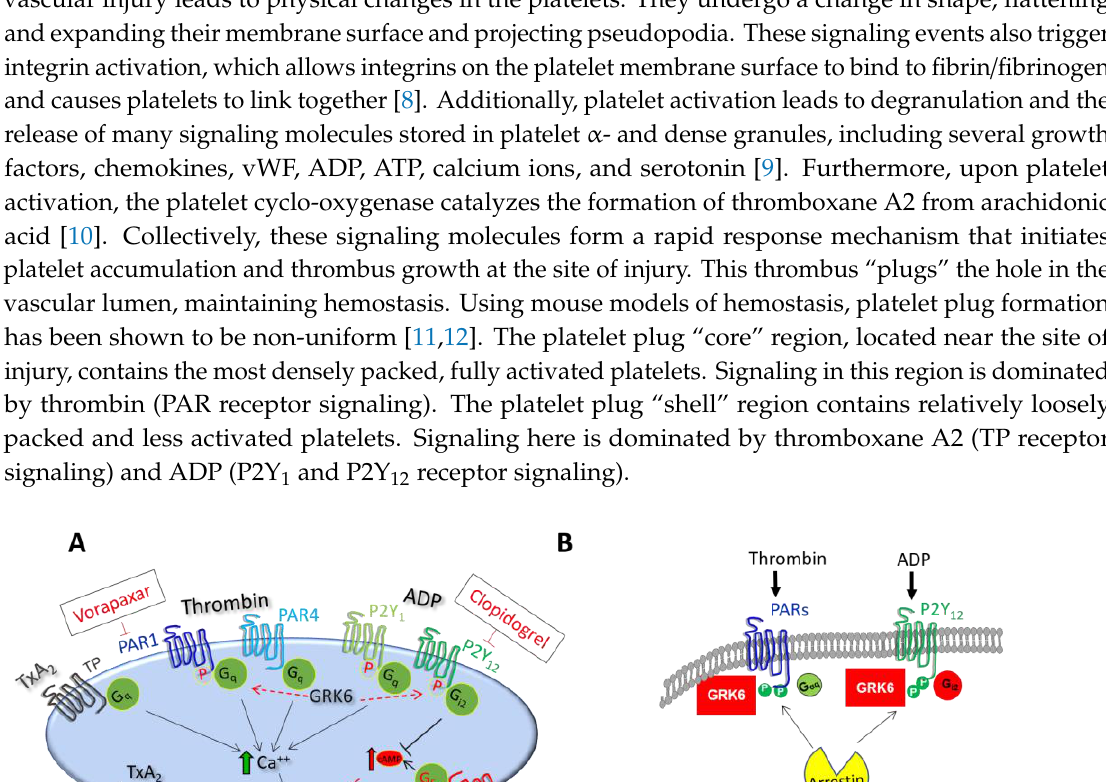
Figure 2. GRK6 regulates the hemostatic response to injury . ( A ) Increased platelet accumulation in GRK6-/- mice following laser injury in a cremaster muscle arteriole as described by Chen et al. [25] Platelets are labeled with fluorescently conjugated anti-CD41 (red), anti-Fibrin (green), and anti-P- selectin (blue). The blue lines mark the vessel walls. The pictures were taken 15, 45, or 170 s after injury. ( B ) The architecture of the hemostatic plug. Left: Hemostatic thrombi formed after penetrating injuries have a characteristic core/shell architecture in which the extent of platelet activation is determined by the distribution and concentration of agonists in the immediate environment of each platelet. The present studies and those discussed in the text show that the thrombus shell is dependent on ADP and TxA 2 , while the core requires thrombin. Right: Knocking out GRK6 causes an increase in PAR4- and P2Y 12 -mediated events, with a rapid increase of platelet accumulation during the early stage of thrombus formation.